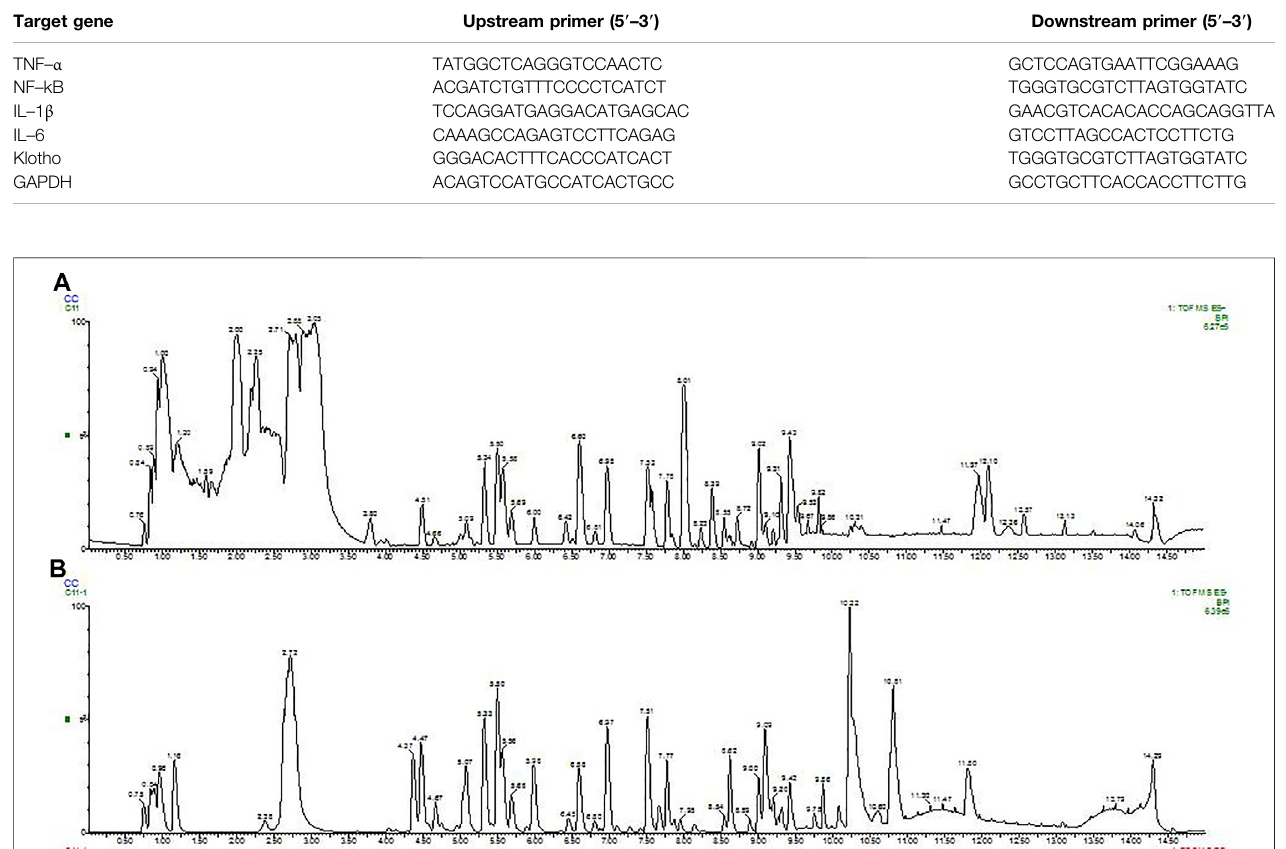
FIGURE 1 | BPI (base peak intensity) diagram of fruit. A: Positive ion BPI (base peak intensity) diagram of fruit; B: Negative ion BPI (base peak intensity) diagram of fruit.